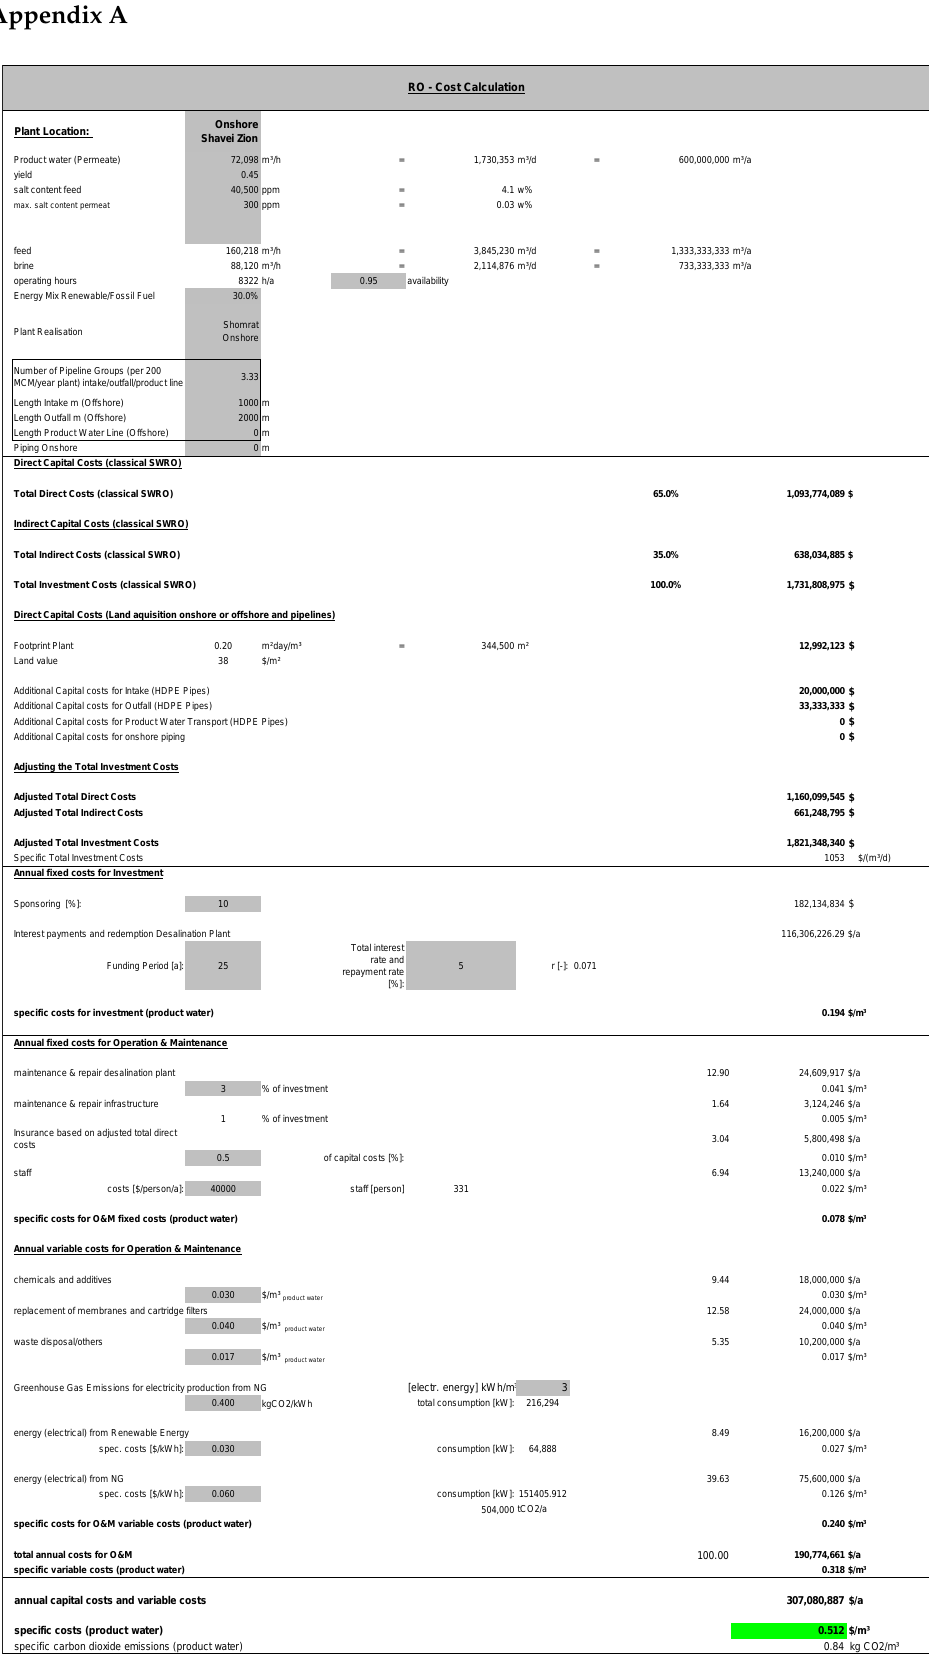
Figure A1 Detailed cost table for the economic analysis — onshore desalination. Figure A1. Detailed cost table for the economic analysis—onshore